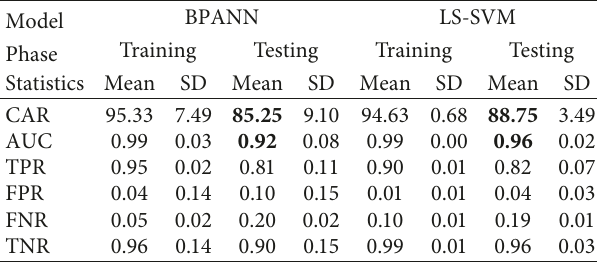
Table 1: Result comparison between ANN and